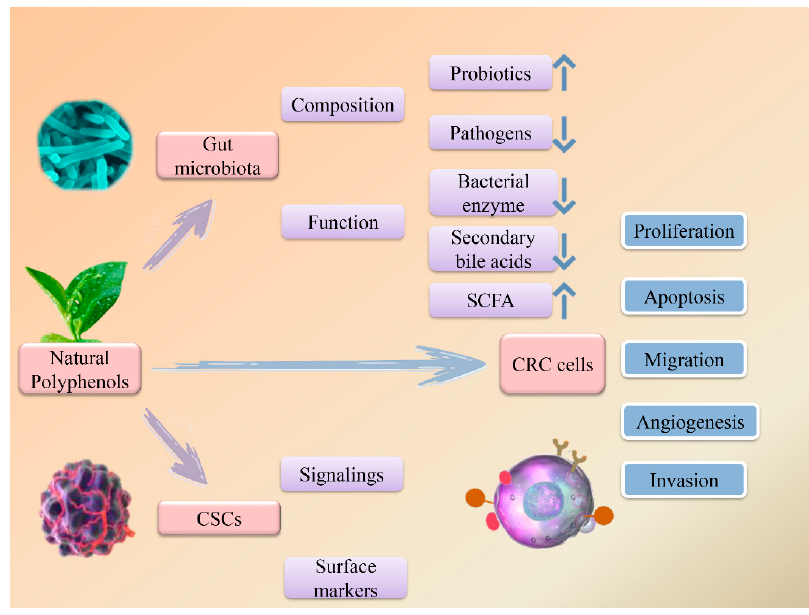
Figure 2. The role of polyphenols in the gut microbiota, cancer stem cells (CSCs), and colorectal cancer cells (CRC).